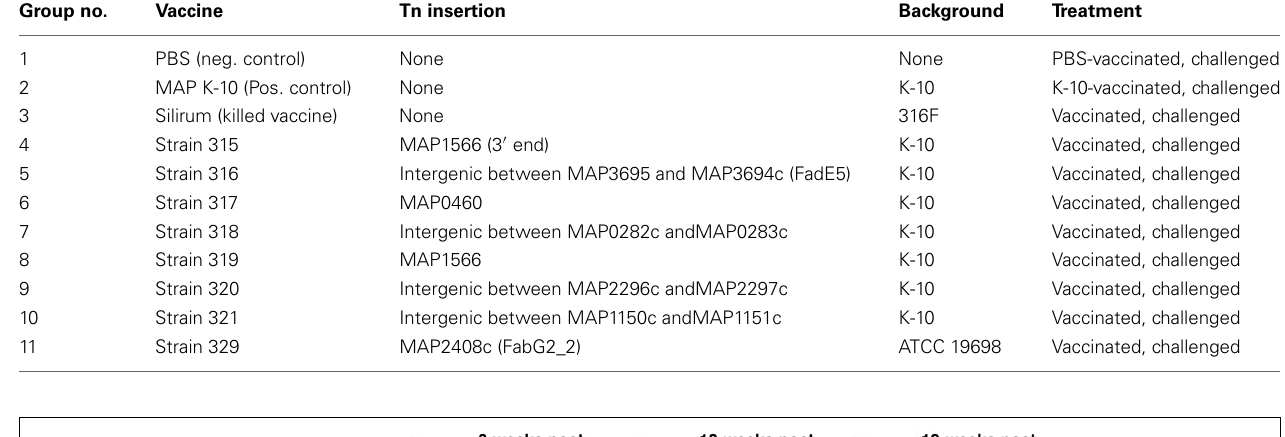
Table 1 | Mouse treatment groups.